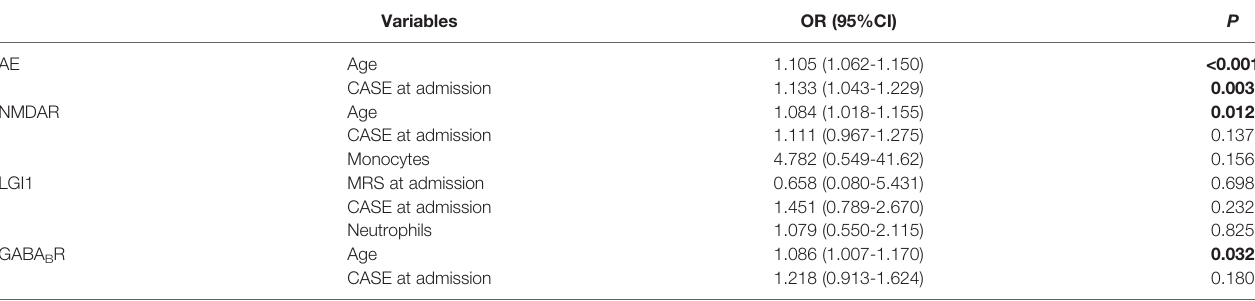
TABLE 6 | Multivariable logistic regression analysis of factors associated with poor prognosis.